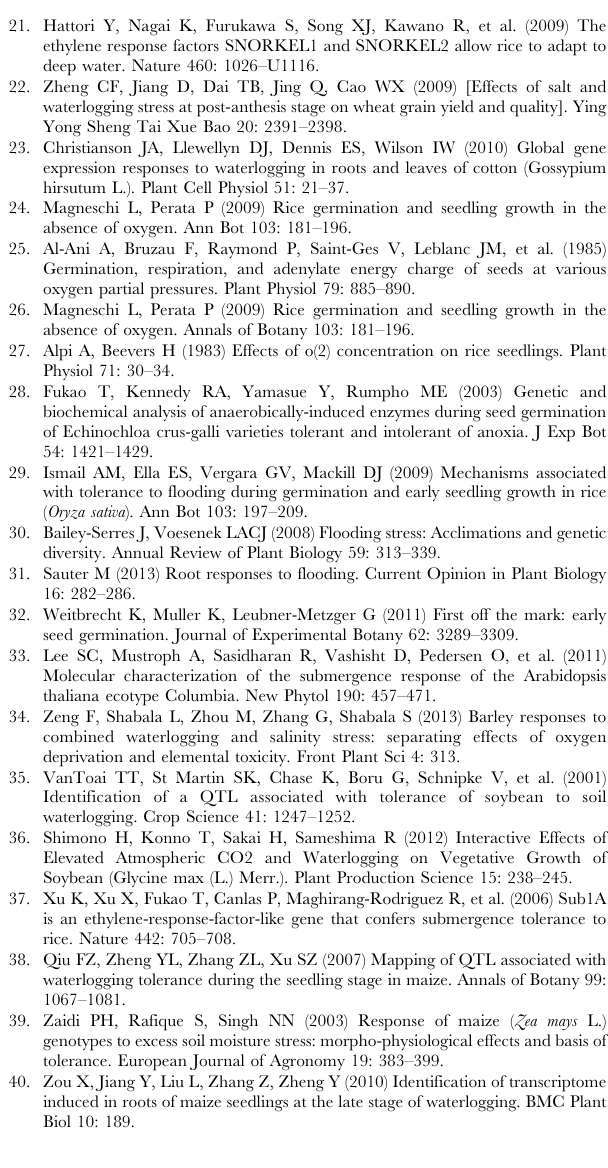
Table S4 Performance-based ranking of the 25 varieties for yield significantly-related traits at seedling establishment stage and seedling